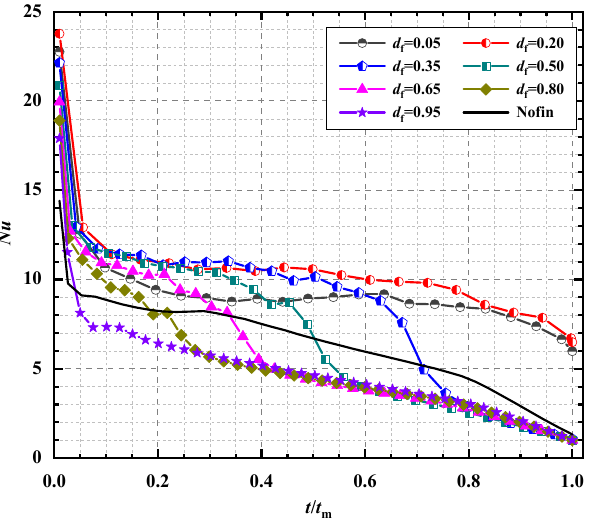
Figure 8. Variation of Nu with normalized, t/t m , for different d f and no fin case. Regime 1: heat conduction regime; Nu decreases sharply from its maximum . At this regime, heat conduction dominates the heat transfer. The conductive resistance of the liquid layer increases from a rather small value, as a result of which Nu decreases sharply as melting goes on.